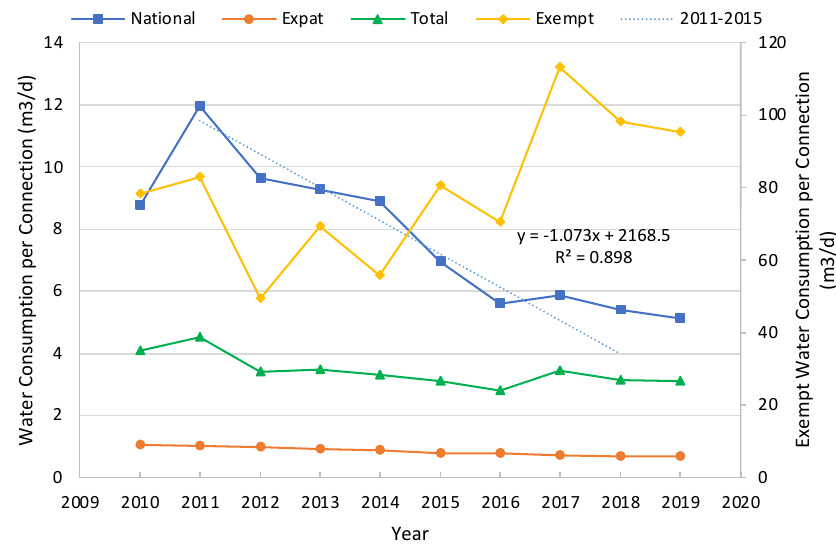
Figure 6. Water consumption per connection for national, expat, and exempt residential categories